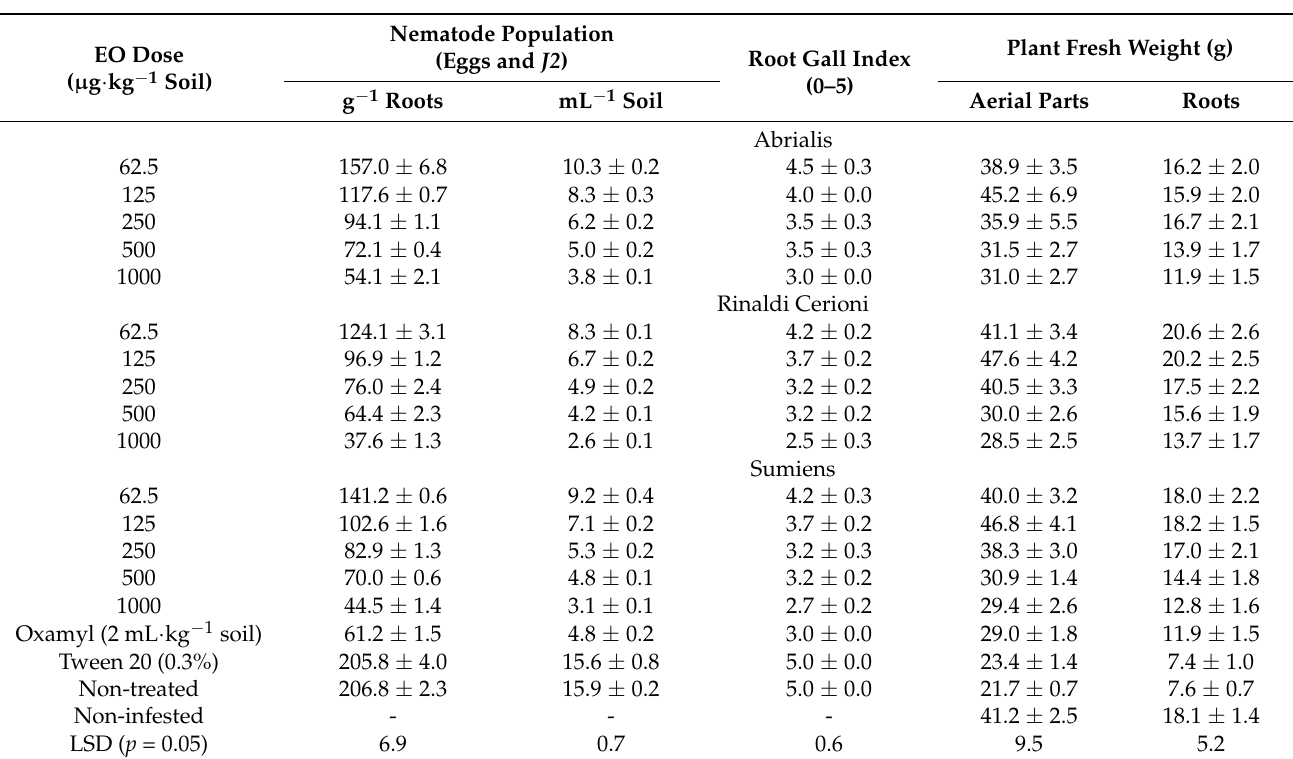
Table 3. Effects (means of five replicates ± SE) of soil treatments with 62.5–1000 µ g · kg − 1 soil rates of EOs from lavandin cv Abrialis, Rinaldi Cerioni, and Sumiens on Meloidogyne incognita infestation on tomato cv Regina di Fasano of the root-knot nematode and tomato plant